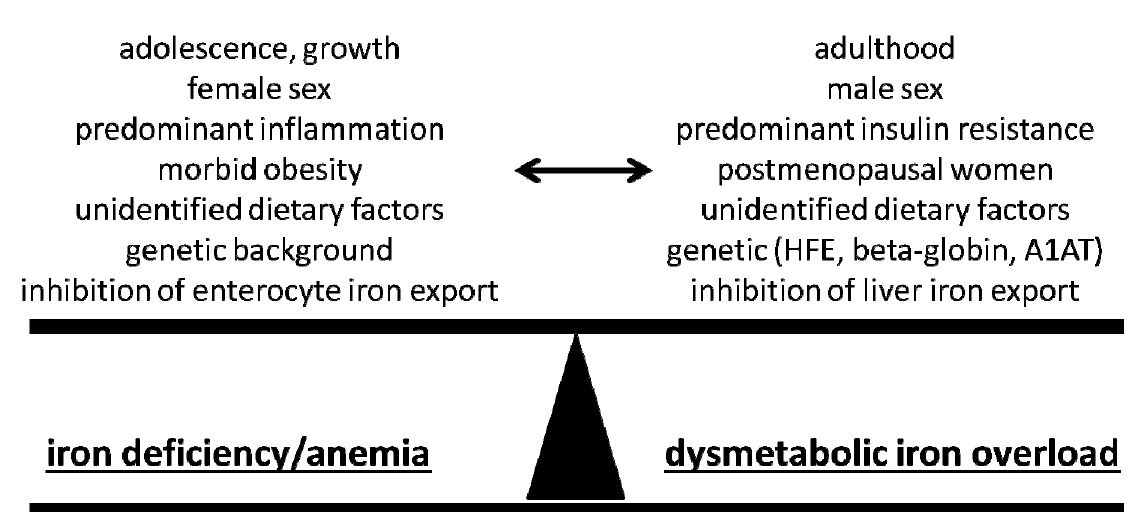
Figure 1. Summary of potential stimuli and characteristics which may affect the manifestation of the iron phenotype in obesity. Both iron deficiency and the dysmetabolic iron overload syndrome represent well-studied manifestations of disordered iron homeostasis. The net balance of underlying, frequently competing stimuli will likely define the iron phenotype in an individual